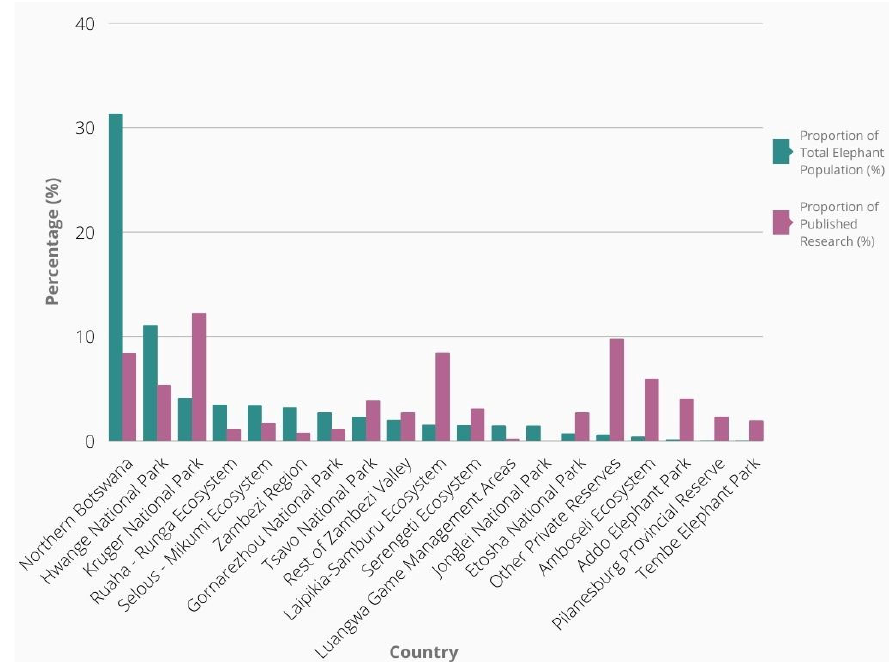
Figure 2. Research and populations by National Parks & Reserves and Protected Areas (NPR/PAs).